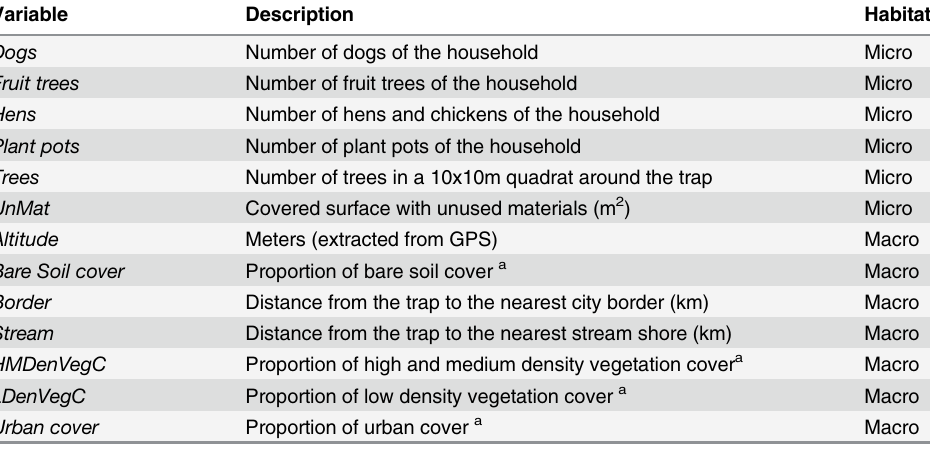
Table 1. Environmental variables used to explain the variation in Lu . longipalpis abundance at Santo Tomé, Corrientes. Variable